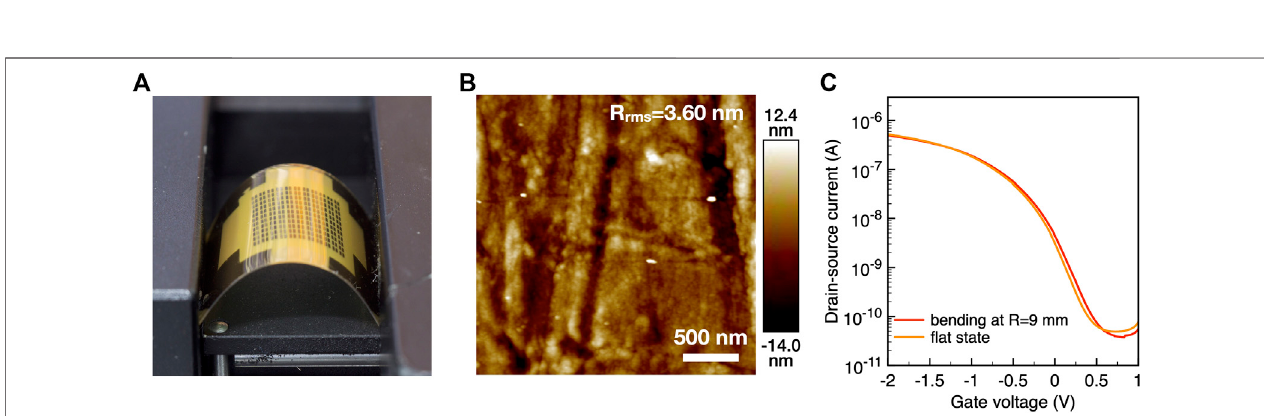
FIGURE 5 | (A) optical image of the fl exible organic transistor device under upward bending; the bending radius is 9 mm. (B) AFM image of the surface morphology of PEN substrate. (C) Transfer I-V curve of the fl exible organic transistor at bending and fl at states.